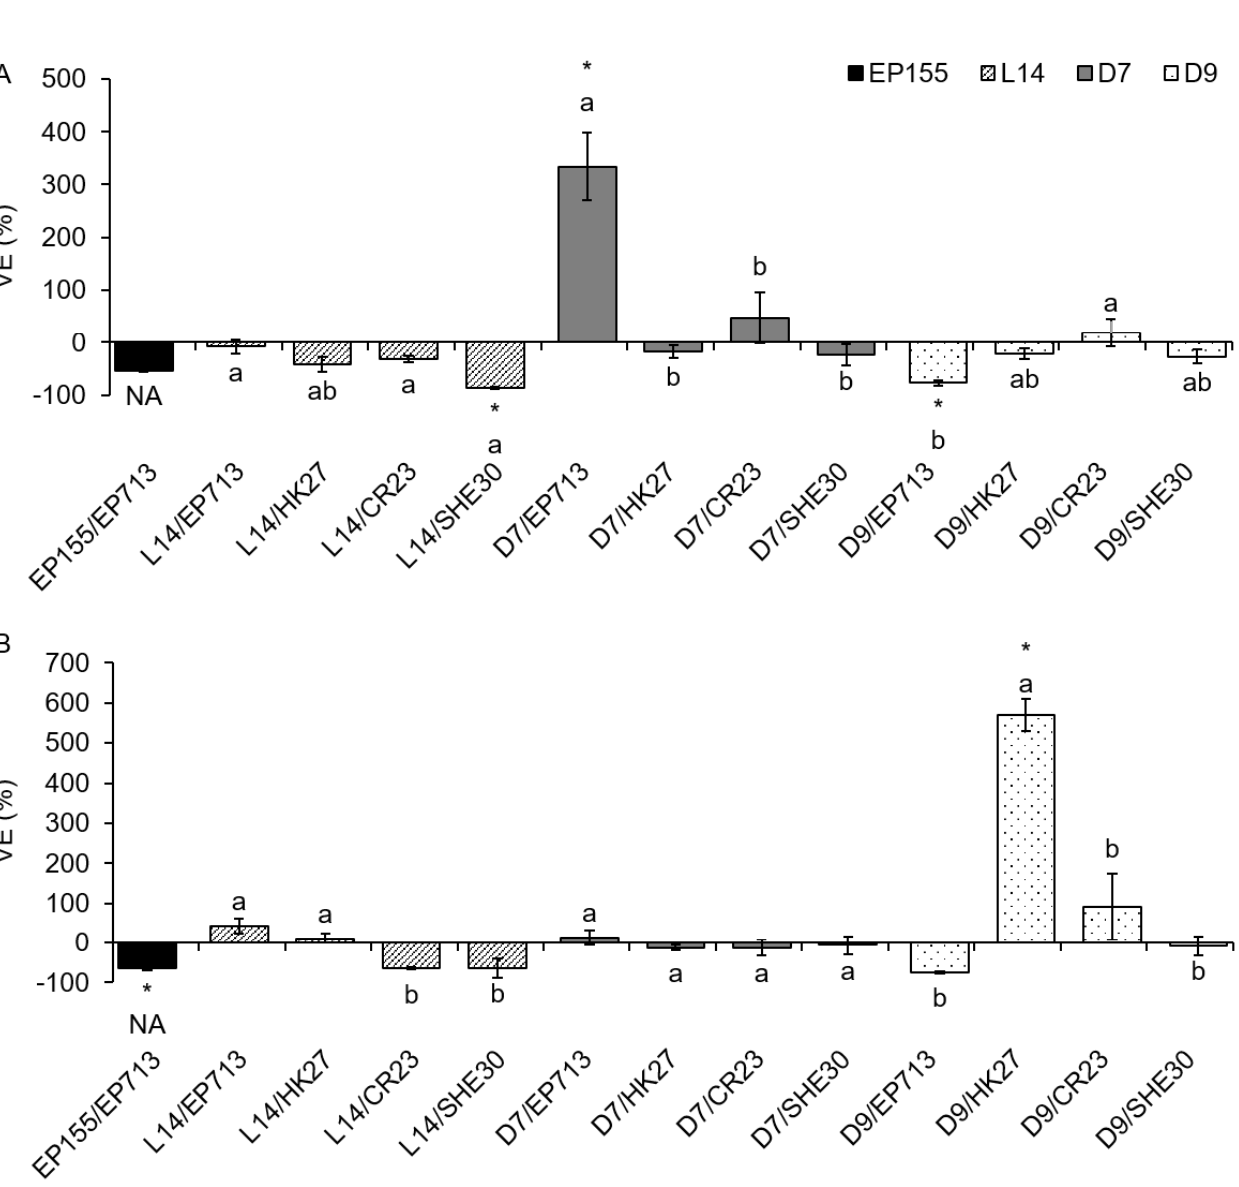
Figure 2. Effect of virus infection on the intracellular laccase (icLAC) activity of four Cryphonectria parasitica isolates when grown on liquid media ( A ) potato dextrose broth and ( B ) malt extract. Results are given as mean virus effect (VE) value (difference between each triplicate measurement of HV isolate LAC activity and the mean of the corresponding isogenic VIR isolate LAC activity, given as a percentage of the performances of the VIR isolate) ± standard error. An asterisk (*) denotes virus-infected cultures with icLAC values significantly different from the corresponding VIR fungal isolate. Letters denote statistical differences between different virus strains infecting the same fungal isolate at p < 0.05. NA = not applicable to the statistical comparison of virus strains due to only one fungus/virus combination.